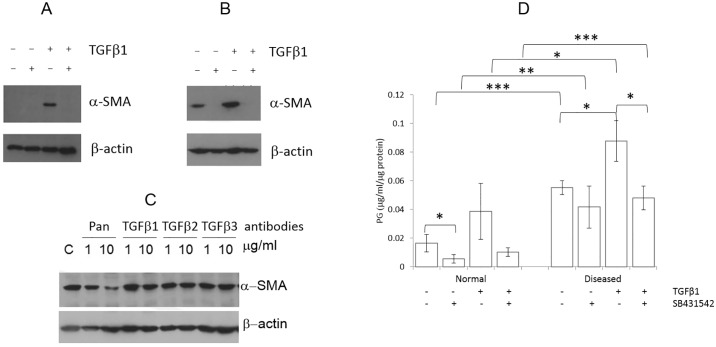
Pharmacological manipulation of αSMA expression.Protein immunoblotting illustrating: (A) Changes in αSMA expression in normal cells treated with vehicle, 5ng/ml of TGFβ1 and 10μM of SB431542 (B) Abolition of αSMA expression in diseased cells by SB431542. (C) Reduction in αSMA expression in diseased cells by treating with a pan anti-TGFβ antibody at 10μg/ml, but not by TGFβ specific antibodies. (D) Changes in deposition of proteoglycans (PG) in normal and diseased cells in response to TGFβ1 and SB4341542. Statistical analysis was performed with Student’s t-test. *, **, and *** P<0.5, 0.1 and 0.01 respectively.